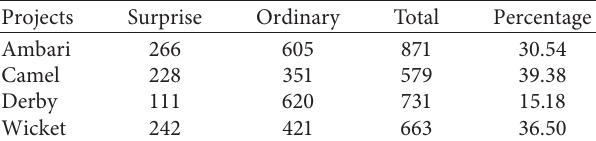
Table 1: The distribution of categories in different projects.